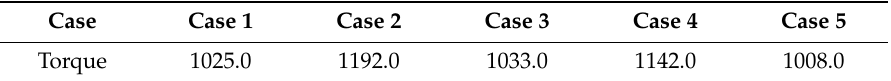
Table 6. Maximum torque